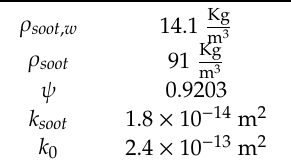
Table 2. Particulate properties.